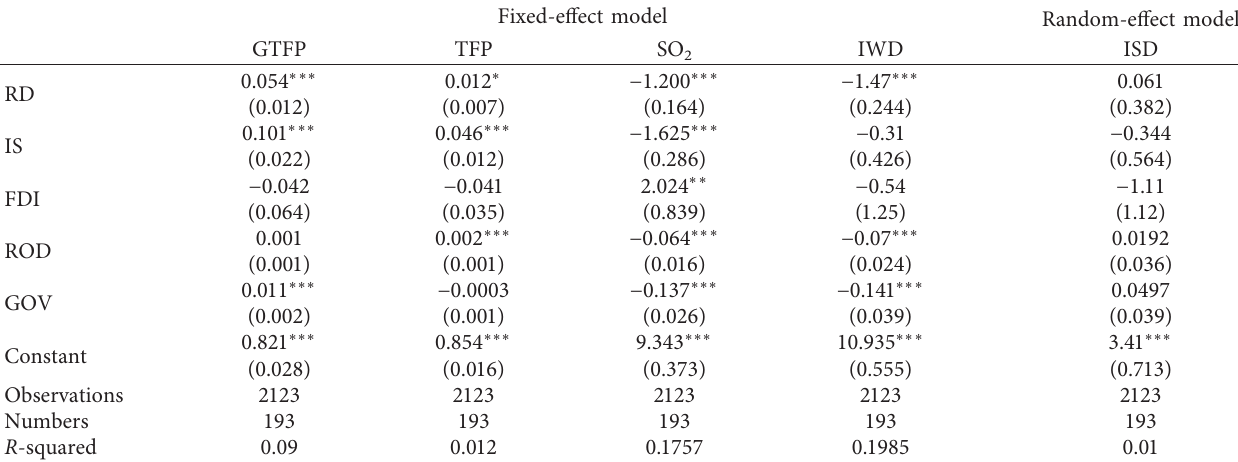
Table 4: Panel regression results of innovation capability on GTFP, TFP, and pollutant